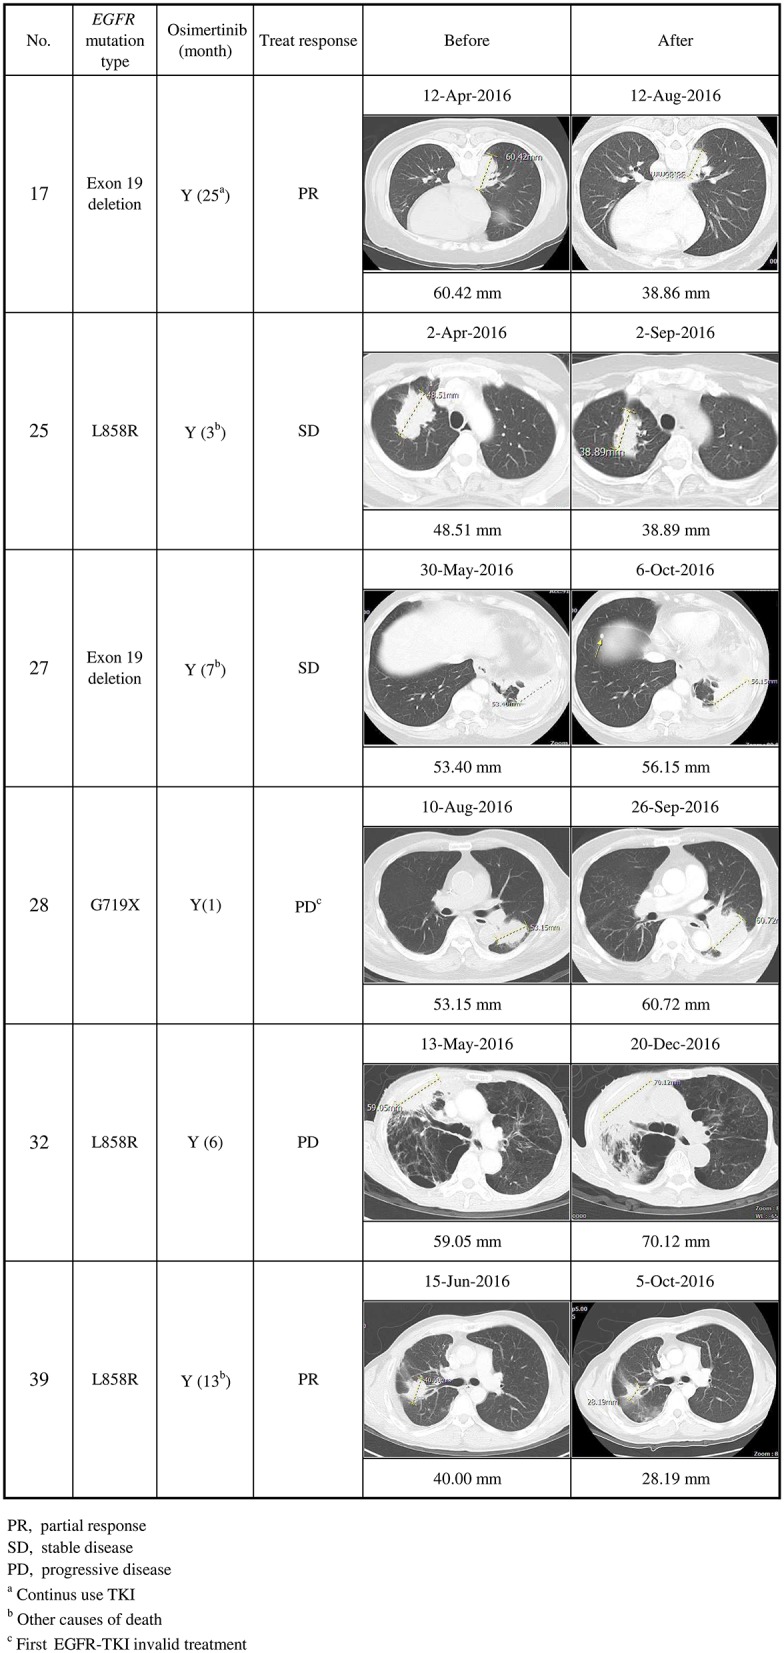
Clinical characteristics of secondary EGFR T790M mutations detected using the in-house method only, and their responses to osimertinib treatment (n = 6). Cases 17 and 39 partially responded, cases 25 and 27 stabilized, and cases 28 and 32 progressed after osimertinib treatment.